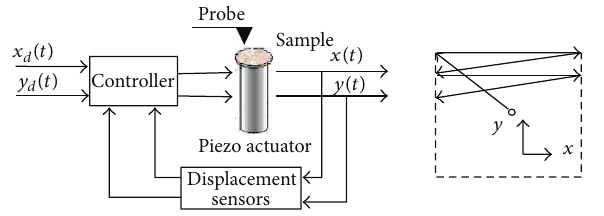
Figure 3: AFM operation diagram and scanning